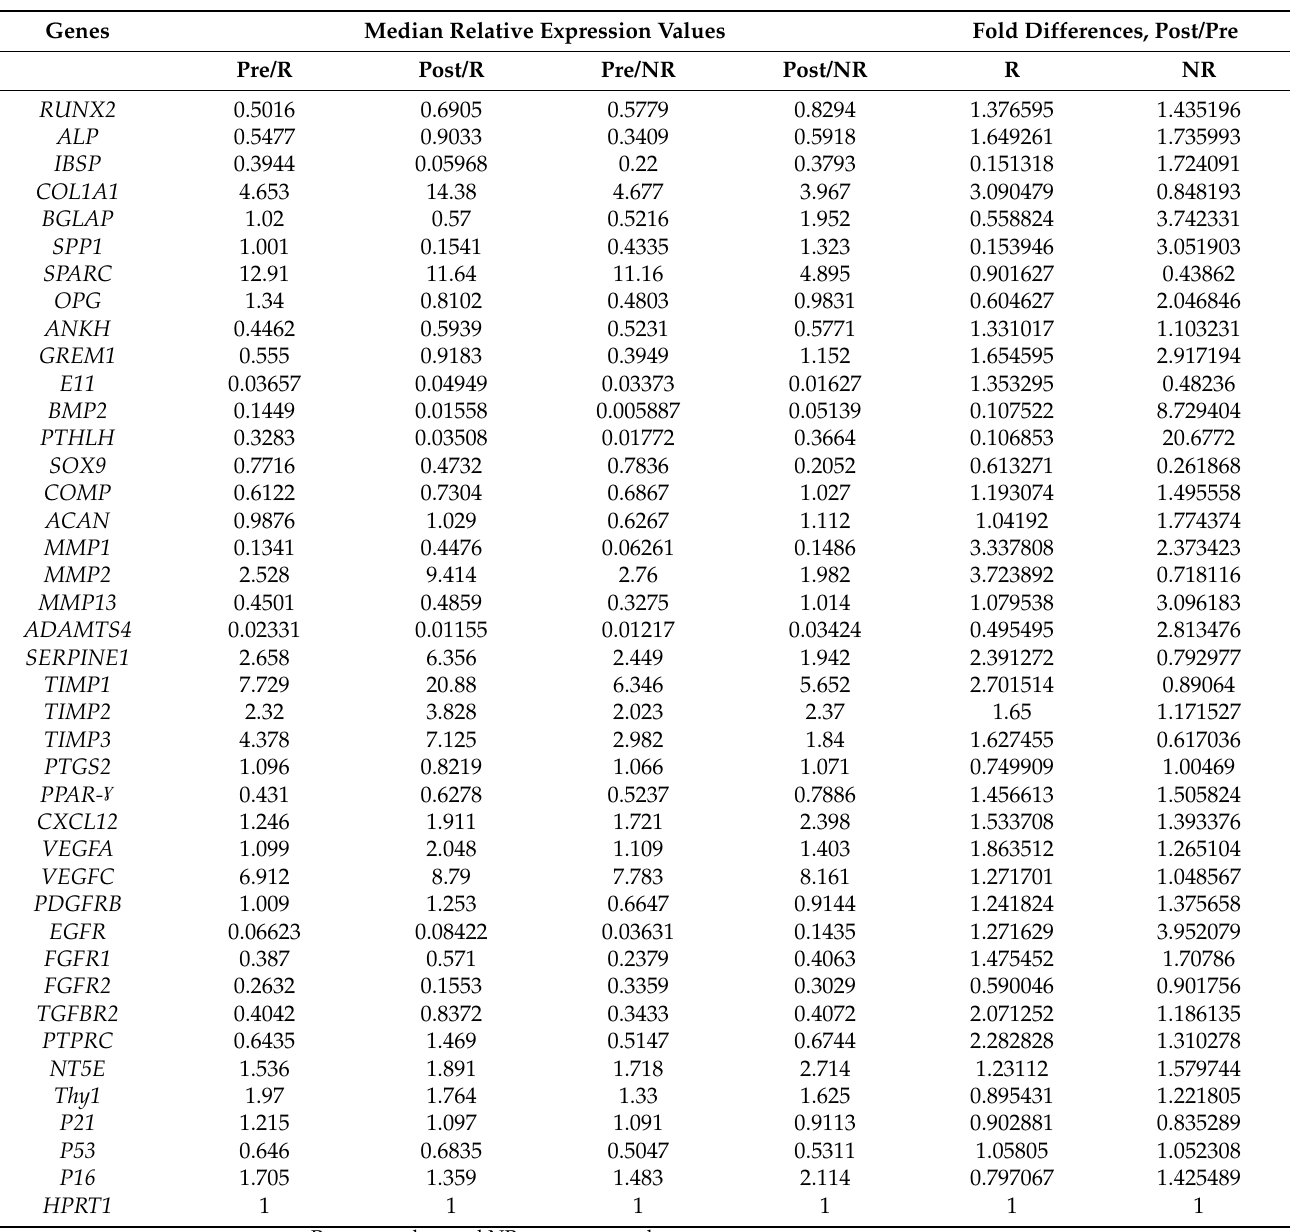
Table 3. A list of the genes with median values and fold differences between the Pre and Post samples in the responders and non-responders.